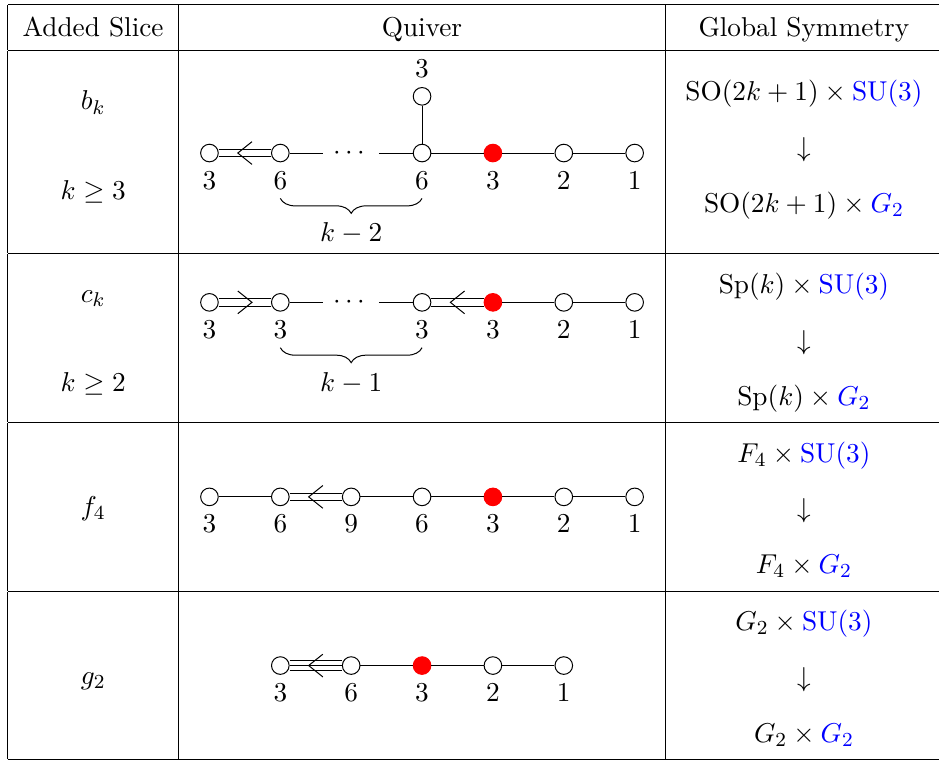
Table 15 . Quivers resulting from adding all possible non-simply laced elementary slices to the empty nodes of sub-regular G (5.1) to absorb a 2